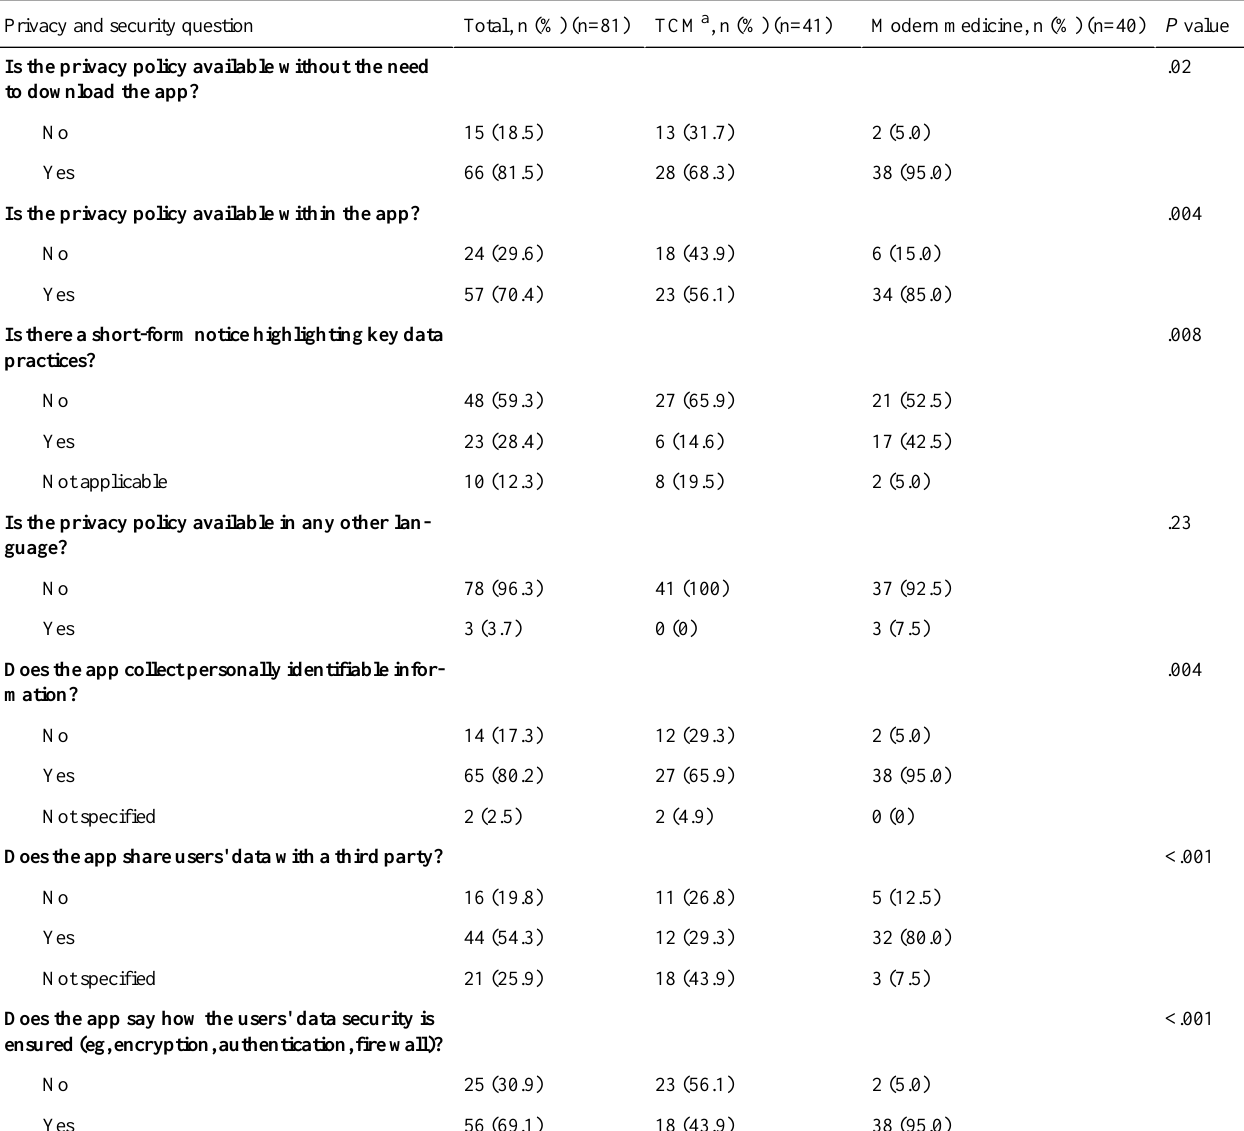
Table 4. Assessment of privacy and security in regard to data gathering, sharing, and security as described in the privacy